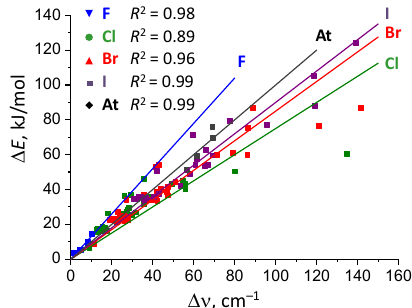
Figure 7. Correlation between calculated complexation energy ∆ E and absolute value of the change of the P = O stretching vibration frequency upon complexation, ∆ ν , for R–X ··· O = PMe 3 halogen-bonded complexes studied in this work (X = F, Cl, Br, I, At). The solid lines correspond to Equation (5).